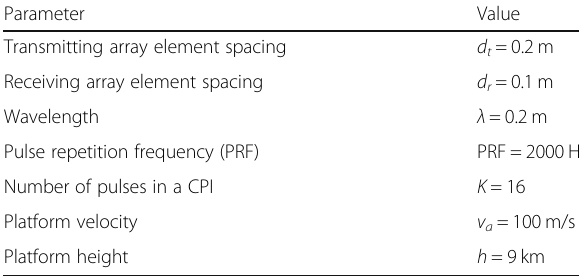
Fig. 9, the bi-iterative algorithm can reach the conver- gence value within 10 steps. Therefore, the total MDN of MIMOBiPer-EFA is